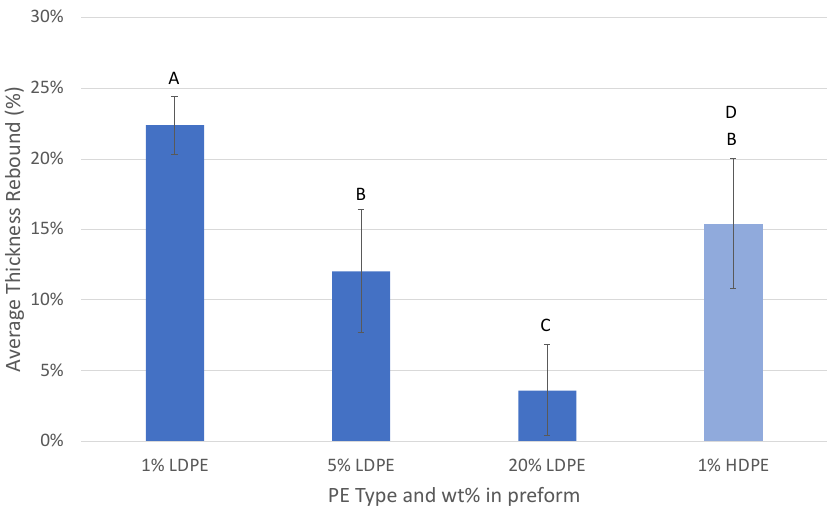
Figure 5. Influence of LDPE content and binder type on the average expansion or rebound of preforms (PE types with the same letter above the bar indicate that their means were not statistically significant).